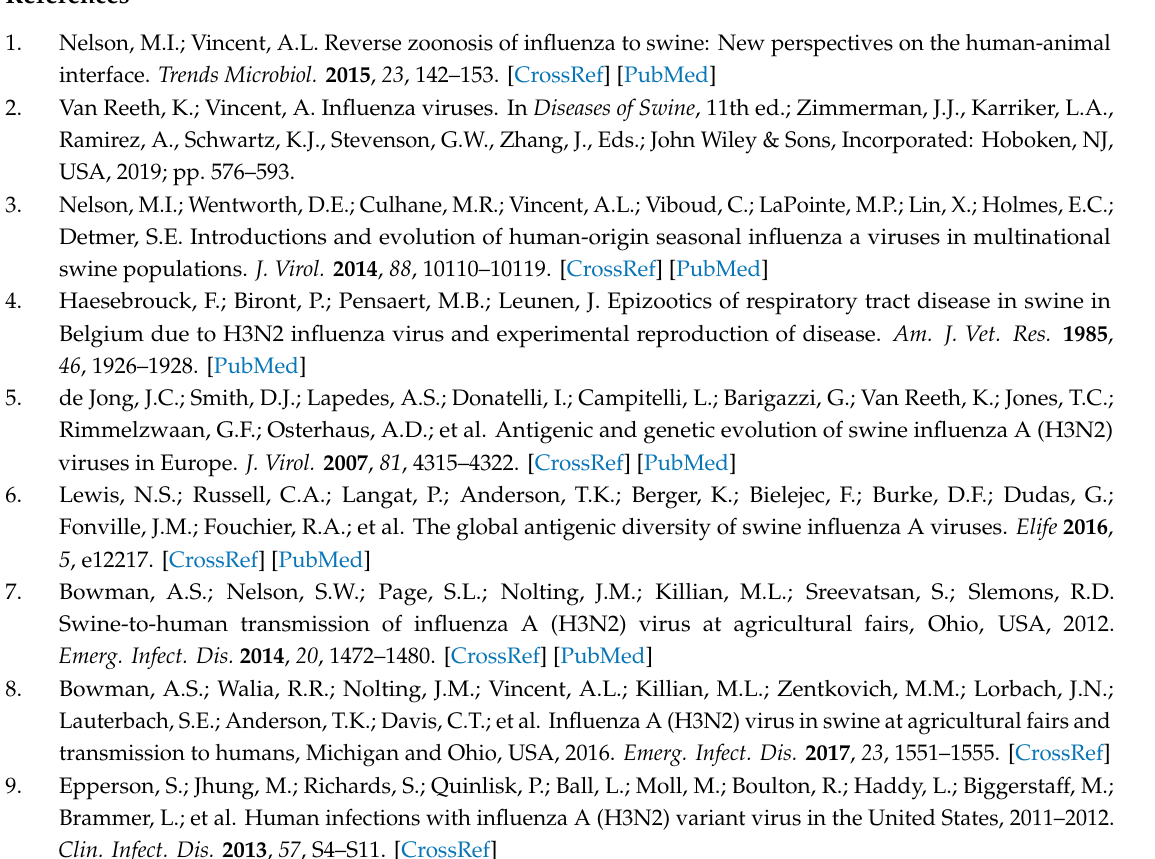
Table S1: Tracheal and lung pathology after challenge with A / swine / Missouri / A01840724 / 2015